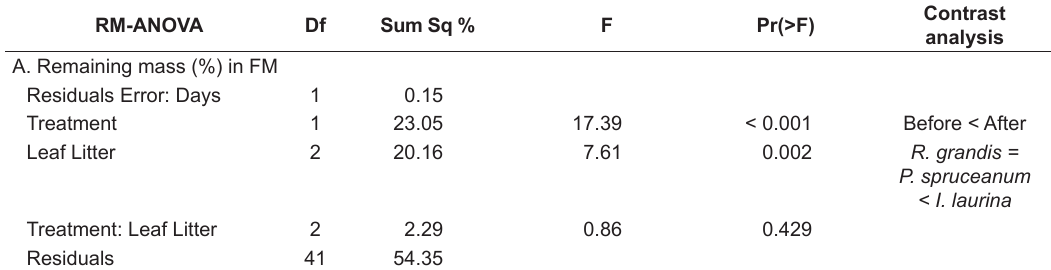
Table 1. Results from RM-ANOVA and contrast analysis (P<0.05) of remaining mass in fine (A) and coarse (B) mesh litter bags, shredder abundance (C), scrapers abundance (D), total invertebrate richness (E), total invertebrate density (F), Ergosterol in in fine (G) and coarse (H) mesh litter bags between two treatments (before and after fire), for leaf litter from three species ( R. grandis, P. spruceanum and I. laurina ), and the interaction between factors.